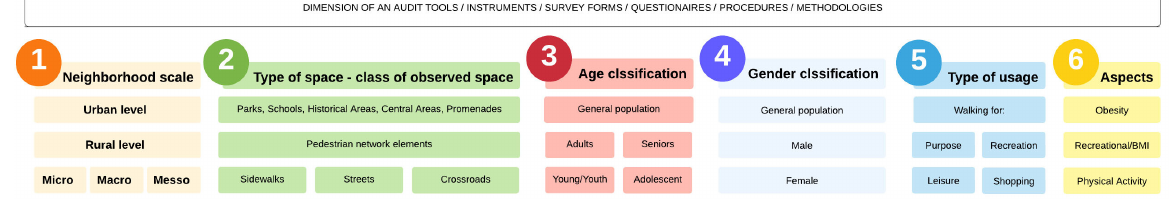
Figure 5. The dimension of observed audit tools survey forms, questionnaires or instruments.